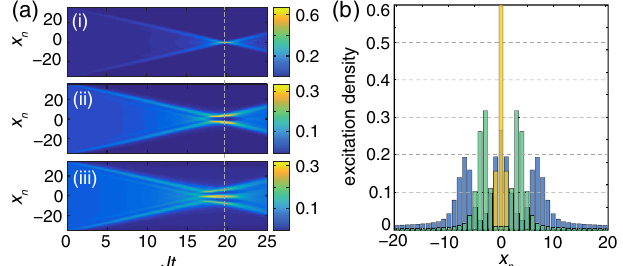
ν Þ FIG. 5. (a) Time evolution of the excitation density p ð n ð t Þ for (i) ν ¼ 1 , (ii) ν ¼ 2 , and (iii) ν ¼ 3 initially delocalized spin excitations according to the nonlinear spin-lens Hamiltonian 4 . 1 a and J 5 × 10 3 J . Eq. (10) with interaction range r B ¼ z ¼ ν Þ ν ¼ 1 (b) Excitation density p ð n ð t f Þ at the focal time t f for (yellow bars), ν ¼ 2 (green bars) and ν ¼ 3 (blue bars) excita- tions, demonstrating spatial spin pattern formation depending on the number of excitations ν